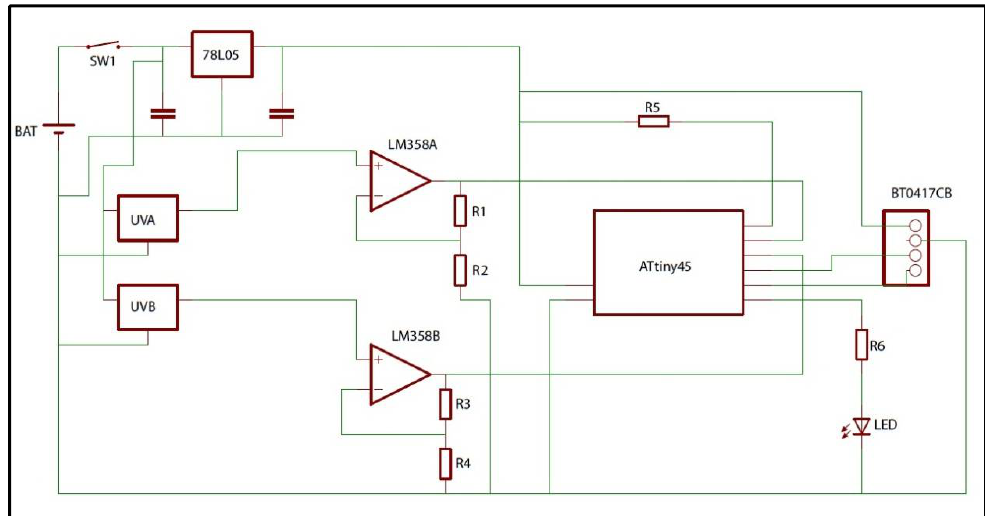
Figure 1. The sensing module blueprint.